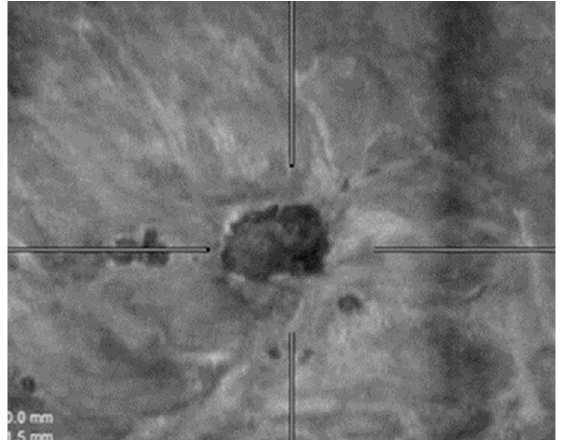
Figure 4. 63-year-old woman with a main nodule (invasive ductal carcinoma biopsy-proven). Other smaller lesions (with a size from 5 to 8 mm) are seen in ABVS and not visualized on conventional HHUS.